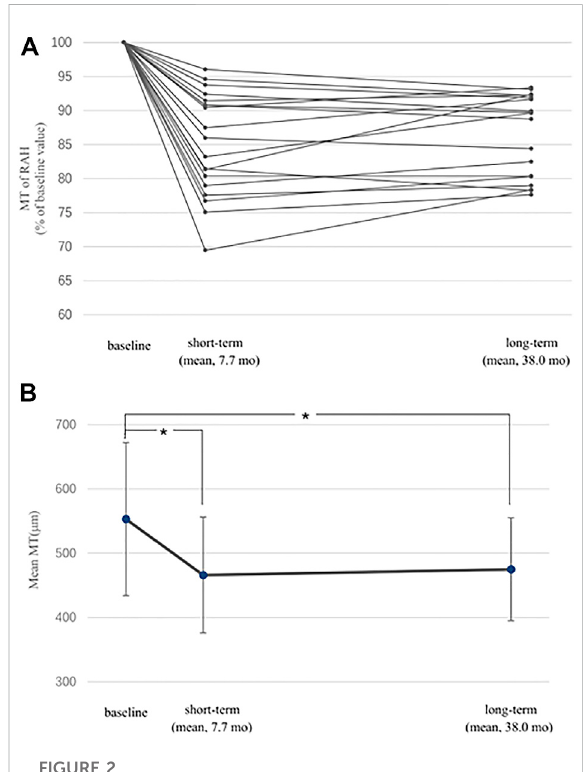
FIGURE 2 Short-term and long-term effects of sirolimus on maximal thickness (MT) of retinal astrocytic hamartoma (RAH). (A) MT of 19 eligible RAHs at follow-ups is expressed as a percentage of the baseline MT. MT reductions were observed in all lesions for both short-term and long-term follow-ups. (B) Signi fi cant difference was found when comparing mean MT of RAHs at the short-term/long-term follow-up with the baseline value (*, p < 0.001). I bars indicate the standard